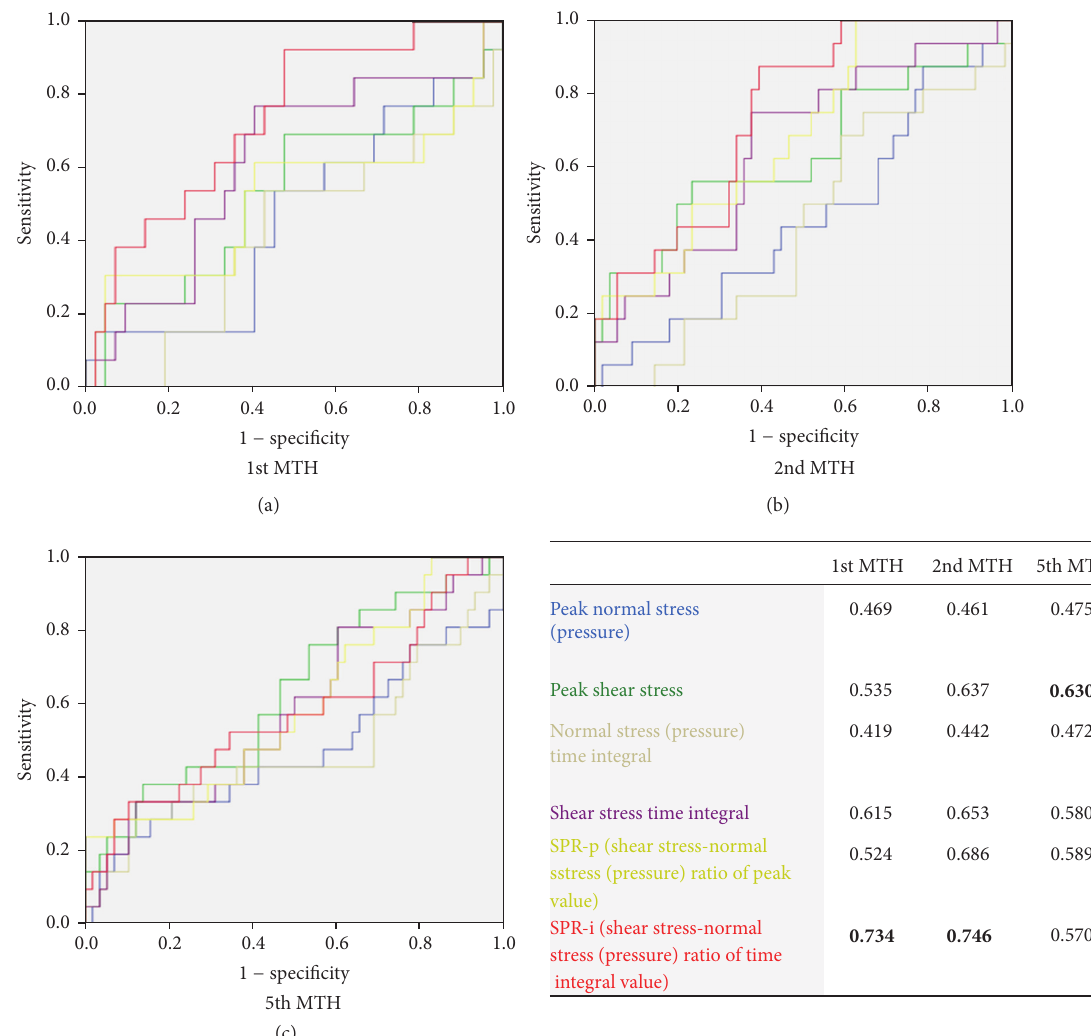
Figure 4: Receiver operating characteristics (ROC) curve of all external force variables in each metatarsal head. (a) 1st MTH, (b) 2nd MTH, and (c) 5th